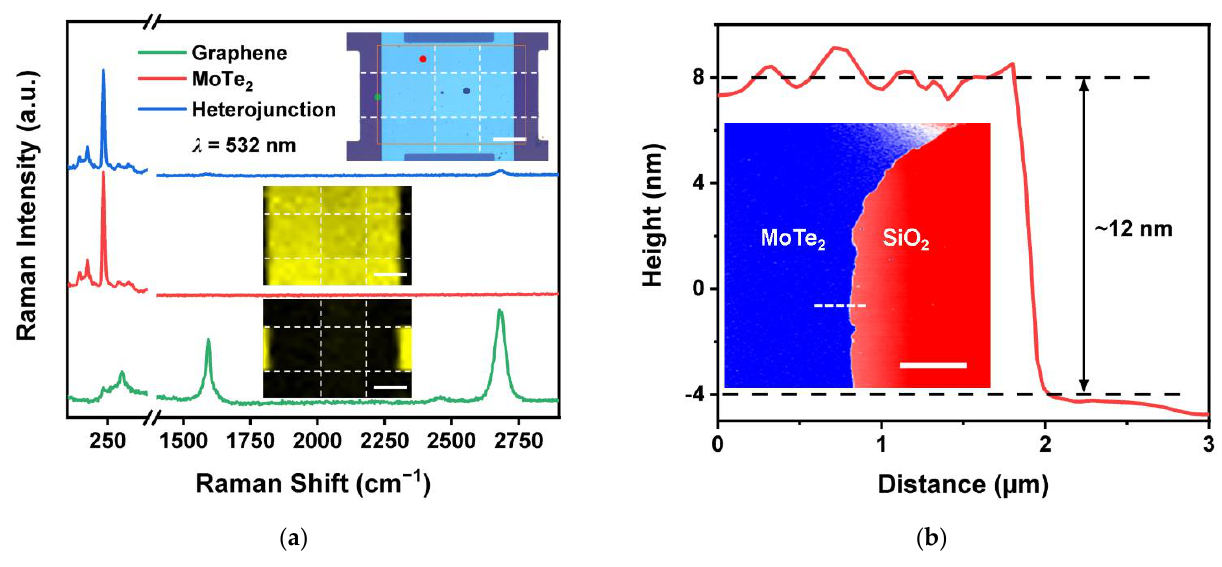
Figure 4. The Raman and atomic force microscope (AFM) characterizations of the graphene and MoTe 2 : ( a ) the Raman spectra measured at graphene, MoTe 2 , and their heterostructure regions, labeled by the green, red, and blue dots, respectively, of a representative device (the upper inset). The white dashed lines delineate the outlines of the bottom (vertical) and top (level) graphene. The light-blue area is MoTe 2 . The Raman spectrum of MoTe 2 shows the Raman characteristic peak of 2H-MoTe 2 at 234 cm −1 . The Raman spectrum of graphene consists of the Raman characteristic peaks of graphene at 1593 cm −1 and 2681 cm −1 . In the heterostructure region, the Raman spectrum shows Raman characteristic peaks of both graphene and MoTe 2 . The middle and lower insets show the Raman mapping images acquired at 234 cm −1 and 2681 cm −1 , respectively, taken in the area labeled by the orange box in the upper inset. The scale bar is 30 µm. It is generally observed that both the overlapping and non-overlapping regions are uniform. Meanwhile, the Raman intensity of the overlapping region is much (slightly) lower than that of the non-overlapping region for graphene (MoTe 2 ); ( b ) the AFM image of the MoTe 2 and the surface height profile along the white dashed line. The thickness of the MoTe 2 is about 12 nm. The scale bar is 5 µm.